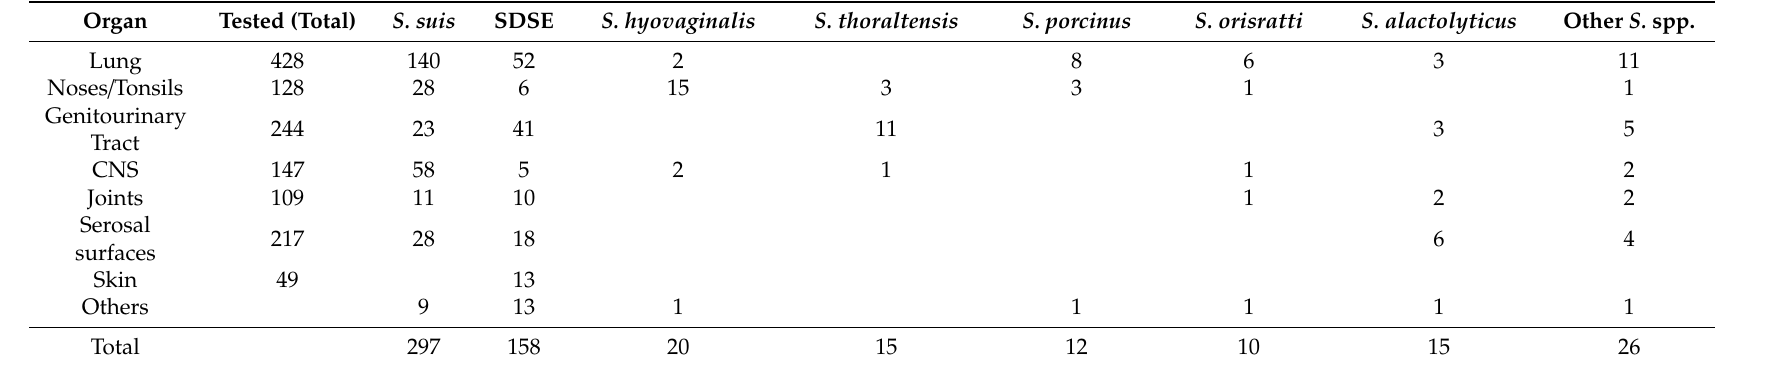
Table 1. Total number of isolated Streptococcus species from di ff erent